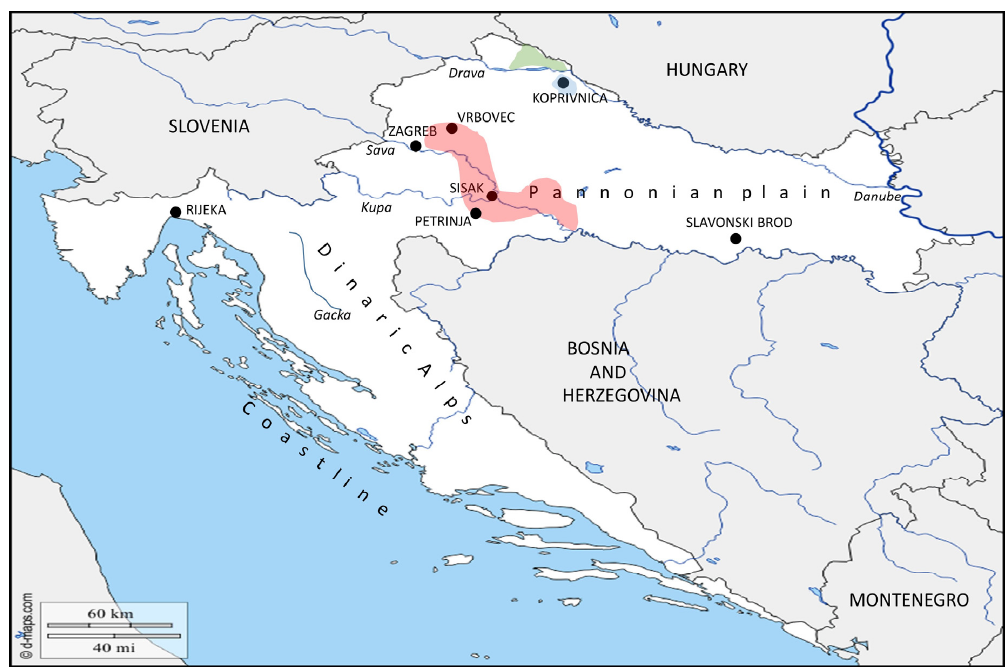
Figure 2. Natural foci of tularemia in Croatia. Three main natural foci of tularemia in Croatia according to Bor č i ć ’s 1974 study were determined. The greatest natural foci were situated along the middle course of the river Sava, in the region called Middle Posavina (red colour), and in two smaller areas located in Me đ imurje, northeastern Croatia (green colour) and around the city of Koprivnica (blue colour), nearby river Drava. Names of the cities and countries are labelled with upper case letters. Names of the three ecological regions are labelled with lower case letters. Names of the rivers are labelled with lower case letters and italic. (Blank maps adapted to source: https://d-maps.com/carte.php?num_car=5352&lang=en.